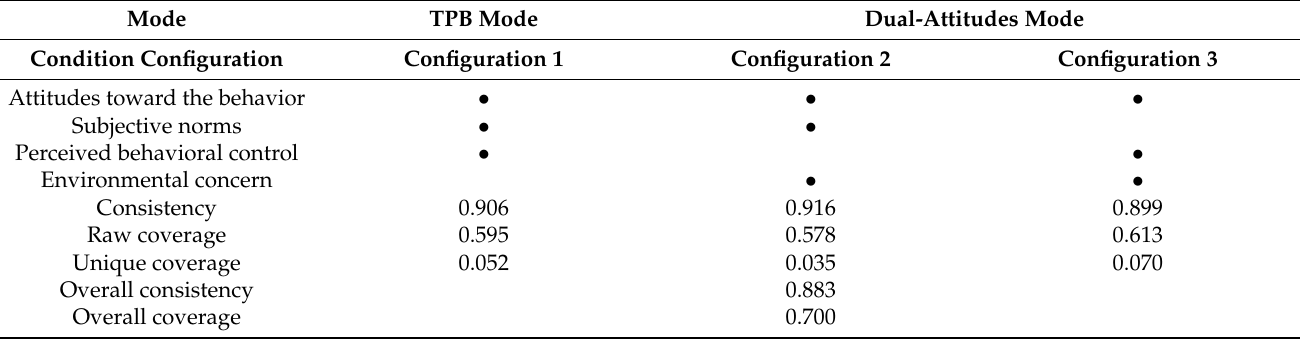
Table 11. Configuration assessment of high-level tourist resource-saving behavioral